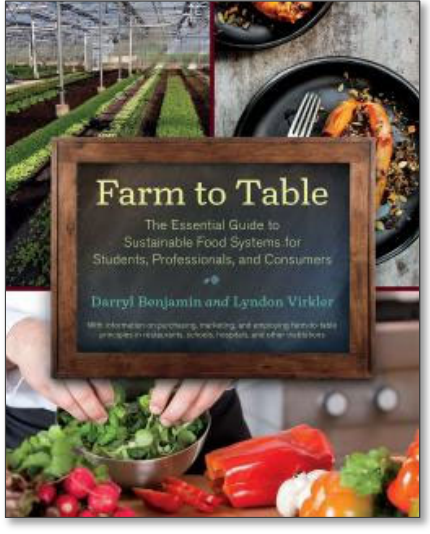
arm to Table: The Essential Guide to